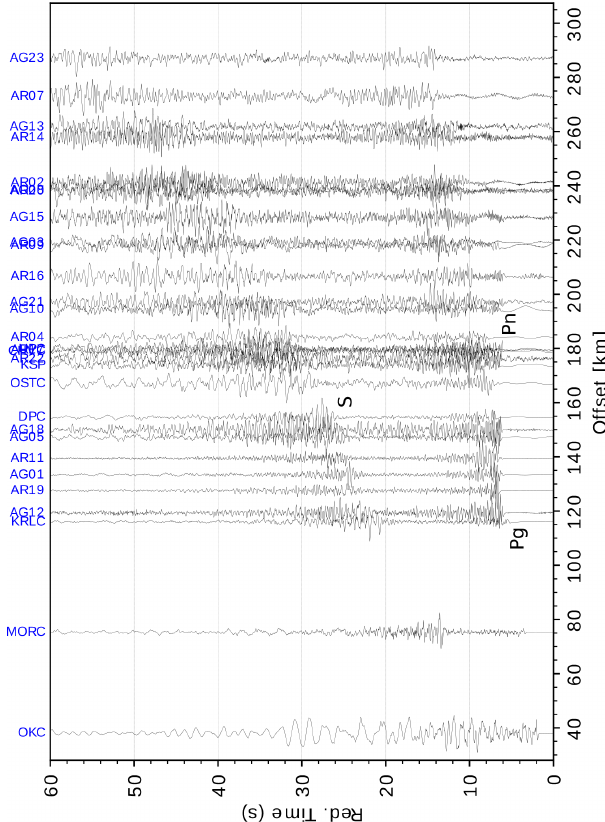
Figure 9. Example of waveforms recorded for the M3.9 local earth- quake which occurred 22 January 2019, 22:35:30.08 UTC in Up- per Silesia district (lat: 50.1095, long: 18.4559, depth: 5.5km after ISC). Band-pass filter 0.2–15Hz was used. Reduction velocity is